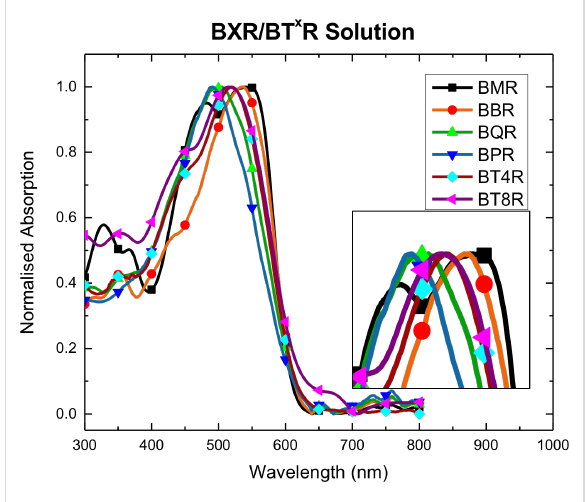
Figure 4: UV–vis absorption spectra of the BX X R series in CHCl 3 . An expansion of the peak area is shown in the inset.